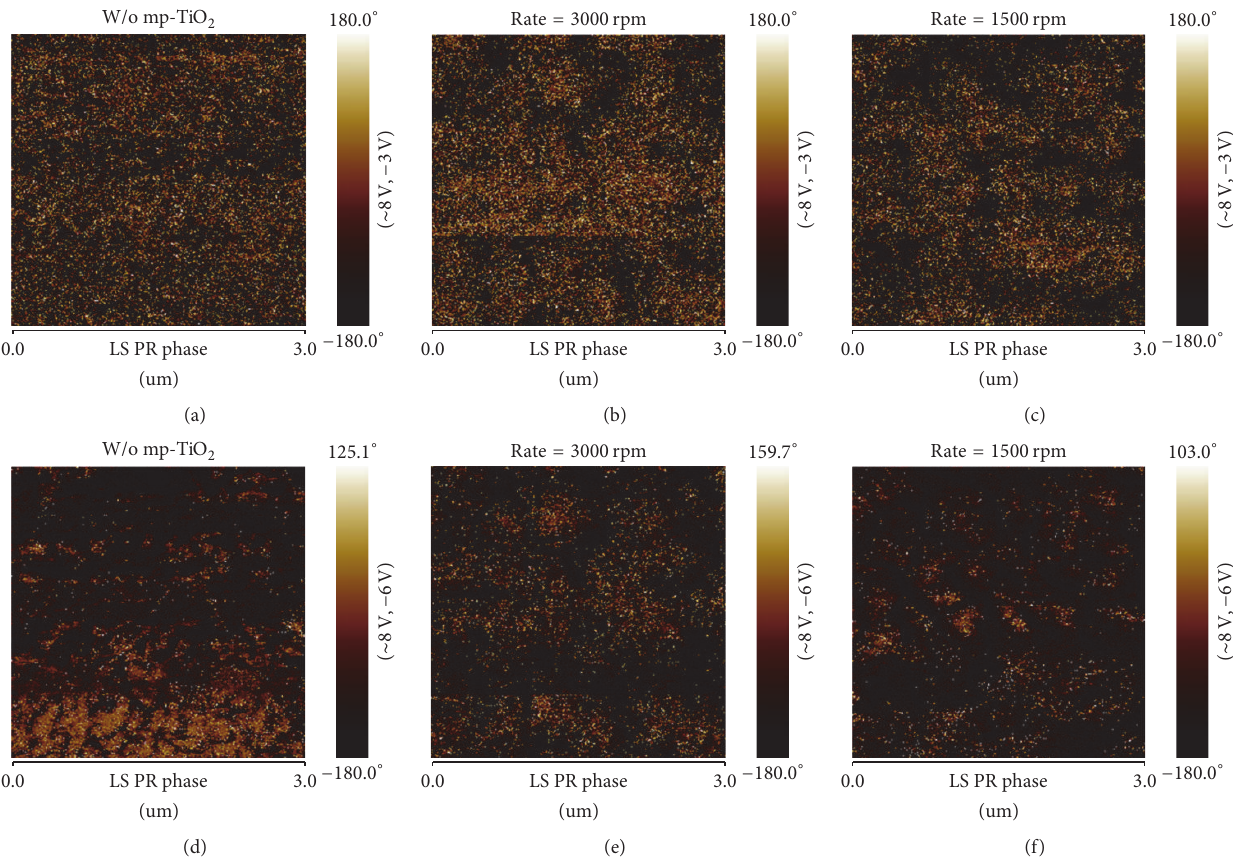
Figure 6: PFM phase images of the CH 3 NH 3 PbI 3 perovskite films which applied ( ∼ 8 V, − 3V) (a) w/o mp-TiO 2 layer and with the spin- coating rate of the mp-TiO 2 precursor for (b) 3000 rpm and (c) 1500 rpm. PFM phase images of the CH 3 NH 3 PbI 3 perovskite films which applied ( ∼ 8V, − 6 V) (d–f) correspond to those which applied ( ∼ 8V, − 3 V) without mp-TiO 2 layer and with the different spin-coating rates of the mp-TiO 2 precursor.